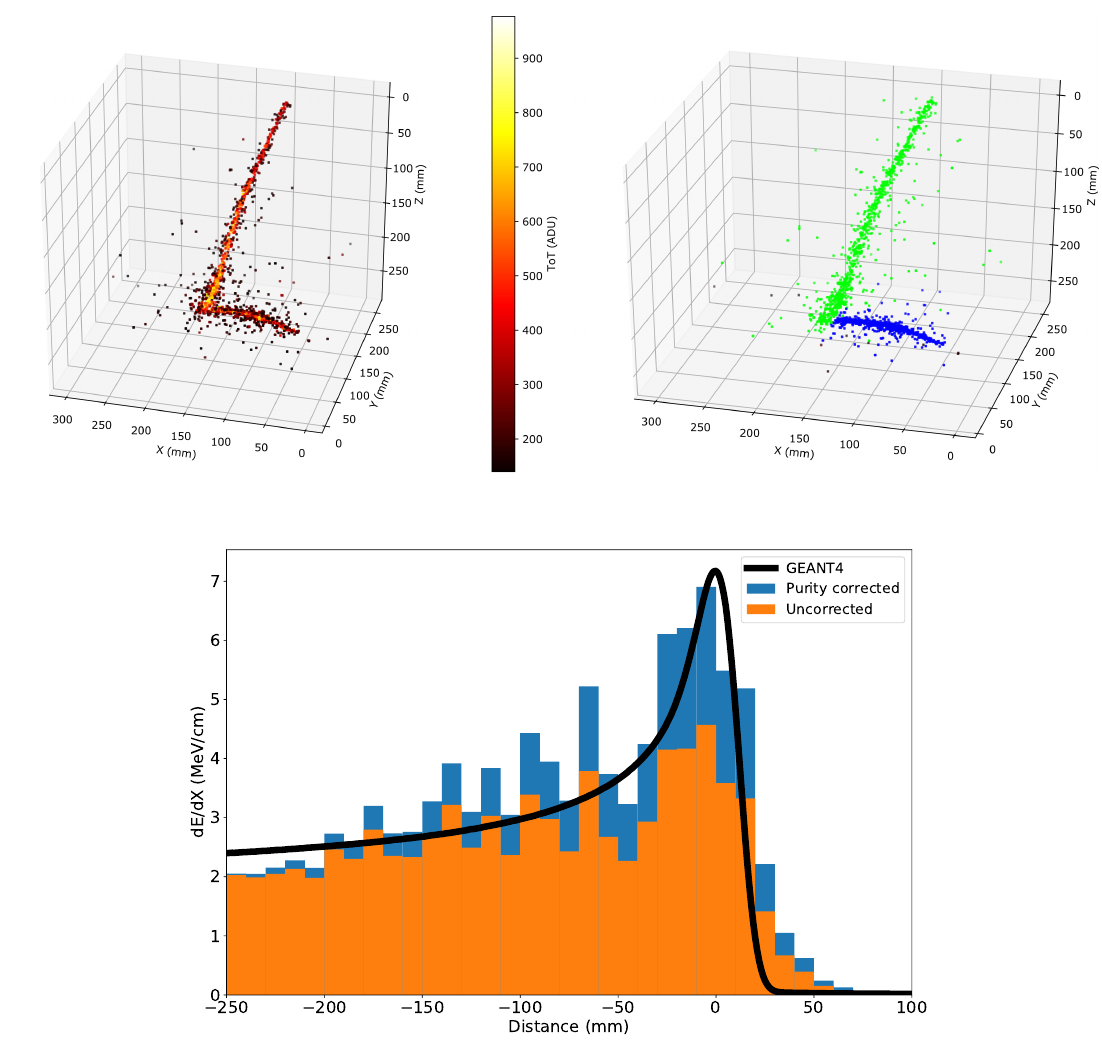
Figure 13. ( Top left ): a stopping muon track plotted with ToT color scale. ( Top right ): the same stopping muon track plotted with hit assignment color scale. Hits assigned to the stopping muon are drawn in green, and hits assigned to the Michel electron are drawn in blue. ( Bottom ): the muon track energy deposition as a function of distance. The zero distance of the track is assigned to the highest bin in the simulated Bragg peak. Negative distances indicate distance backwards along the stopping muon